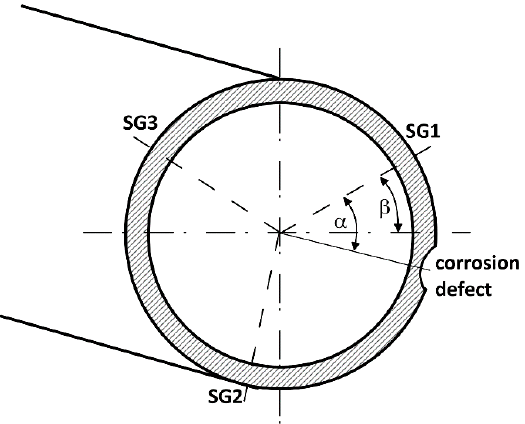
Figure 12. The location of the corrosion defect in relation to a strain gauge 1 (SG1).